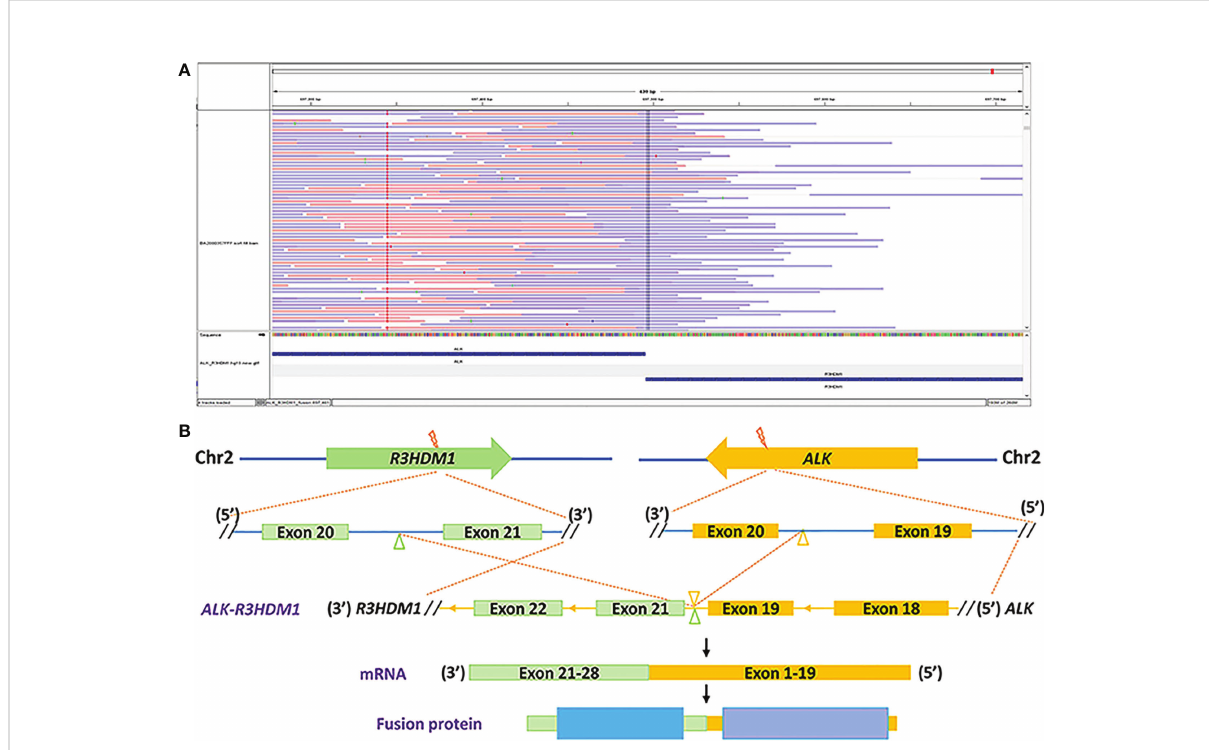
FIGURE 3 Identi fi cation of the ALK-R3HDM1 fusion by next-generation sequencing. (A) Integrated Genomics Viewer snapshot demonstrating the ALK- R3HDM1 translocation. (B) The schematic structure of the genomic DNA sequence shows the ALK-R3HDM1 fusion